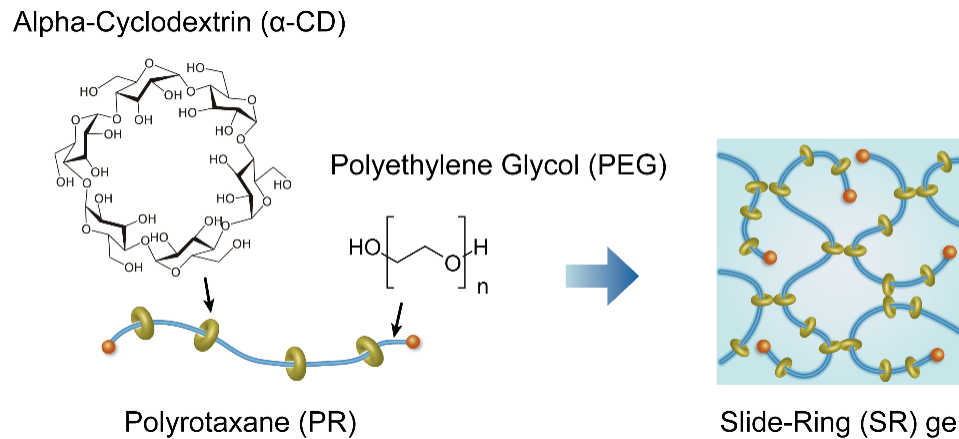
Figure 1. Schematic illustrations of PR and SR gels. Reprinted from [31] with permission from Else- vier.